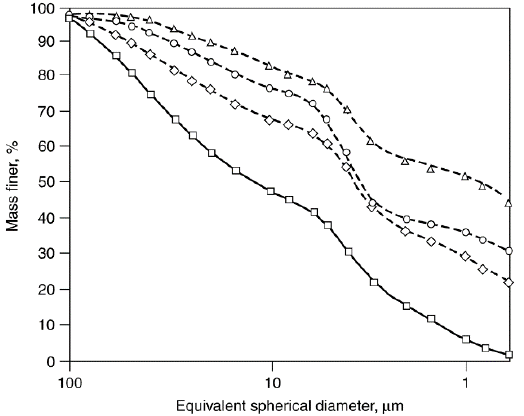
Figure 28. Sedigraph particle size distribution for a United Catalysts, Inc. (UCI) Fischer-Tropsch catalyst (designated as UCI-LAPI-COMP-DRUMC), used previously in Department of Energy (DOE) pilot-plant tests. There is considerable particle breakdown and generation of fine particles after 15 min of ultrasonic irradiation. Reproduced from